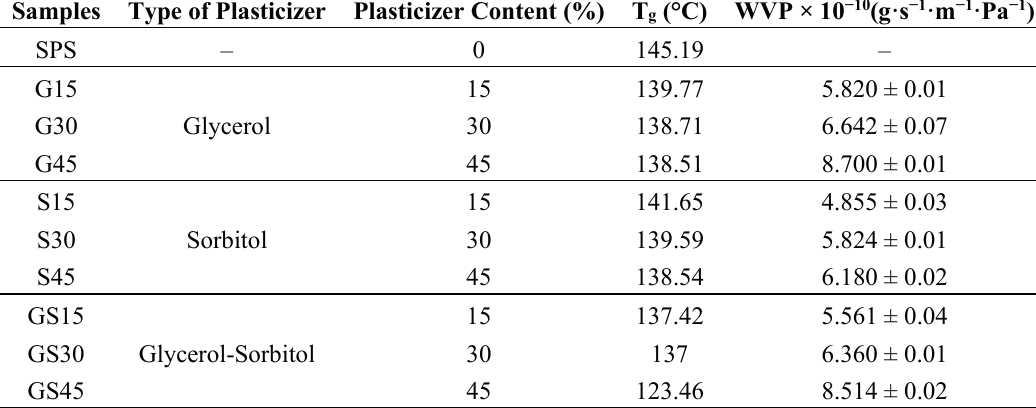
Table 1. Effect of plasticizer type and concentration on T g and water vapour permeability (WVP) of SPS